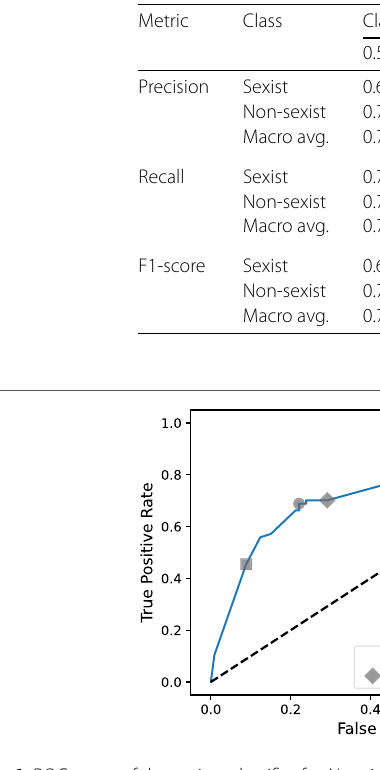
that at least N B batches contain sexist content. In the main text, we considered N B = 1, meaning that one batch of lines labeled as sexist is enough to propagate the label to the whole song. The optimal classification threshold is chosen as the threshold maximizing the F1-score on the external dataset [42] of sexist songs in order to balance both precision and recall. This corresponds to a threshold equal to